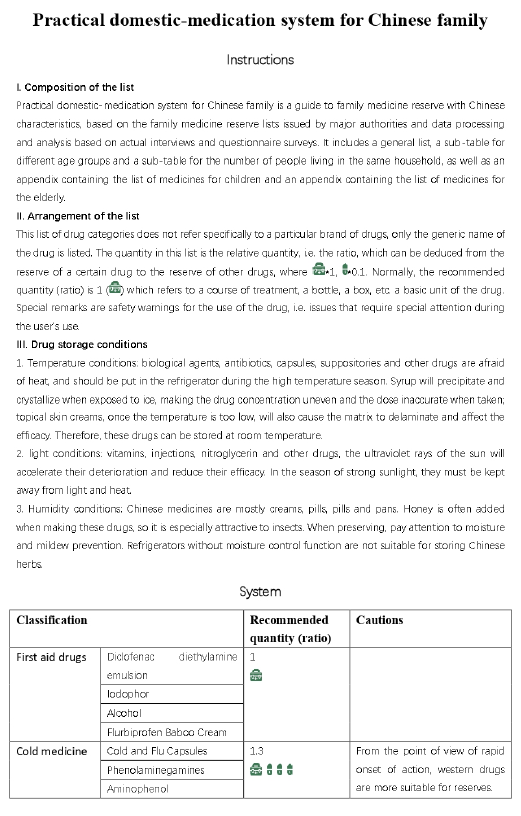
Figure 16. Final practical domestic-medication system.